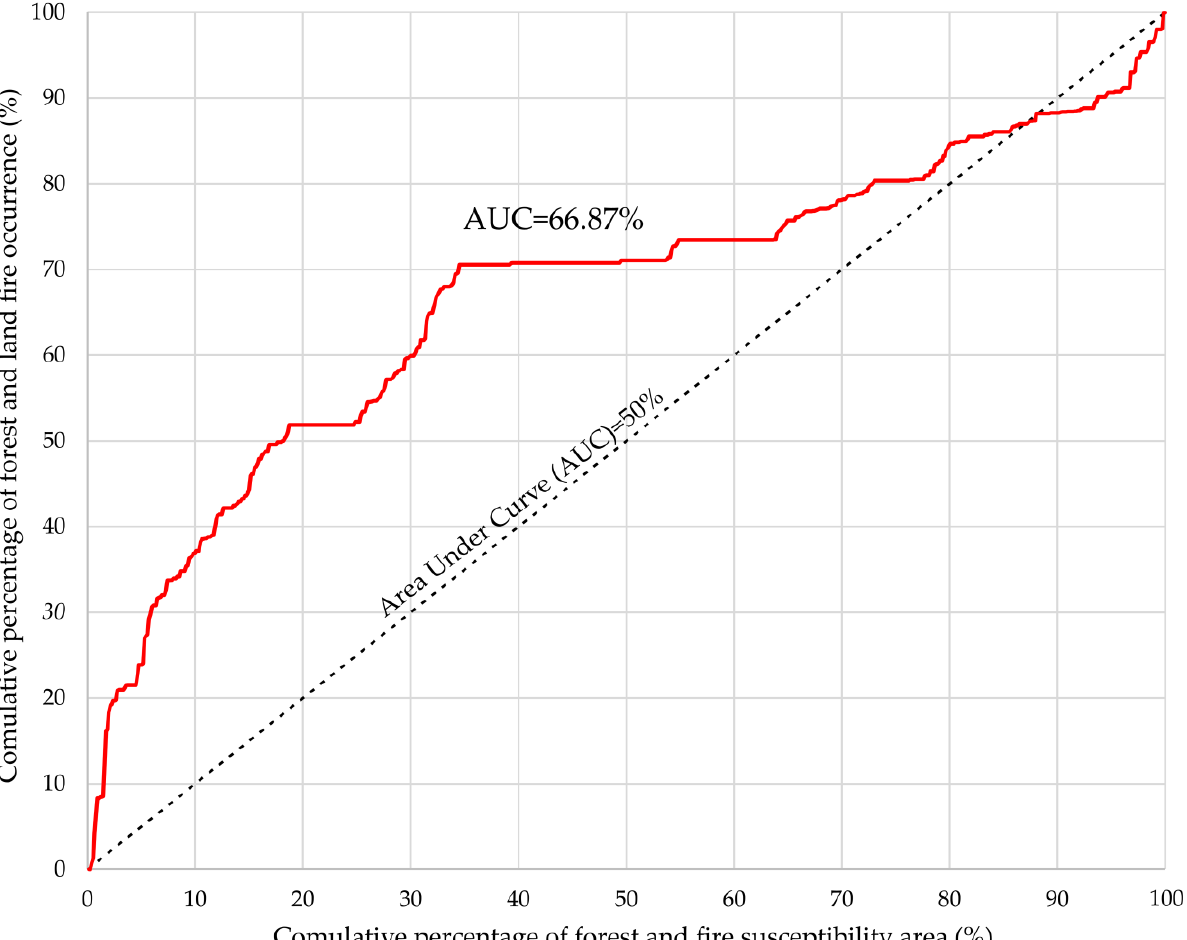
Figure 6. Accuracy of forest and land fire susceptibility using IVM.